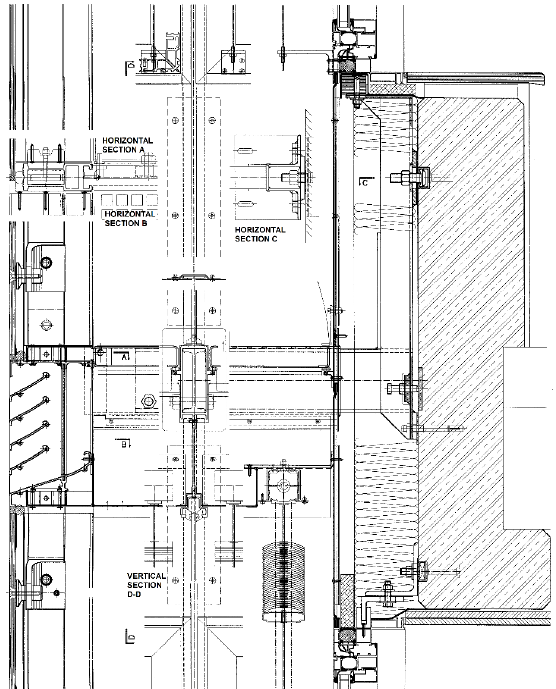
Figure 9: The characteristic vertical section of the double skin fa- cade showing the compatibility of its basic and complementary theoretically justified structural elements and details into a com- plete structural